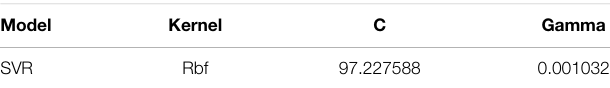
TABLE 3 | Hyperparamers for SVR model.